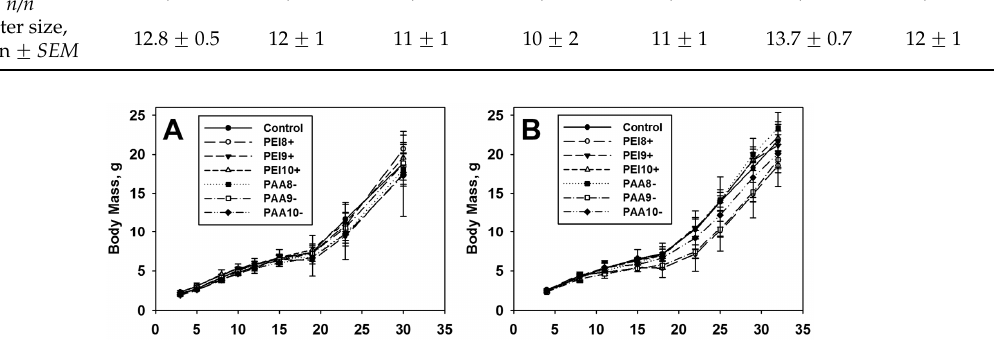
Table 4. Litter parameters for offspring exposed to 10 mg/kg ( A ) or 100 mg/kg ( B ) of iron oxide NPs on GD 8, 9, or 10 in utero . Litter size represents results from cesarean evaluations and pups birthed naturally. * Significant differences between treatment and control ( p < 0.05). Controls from both replicates were combined for litter size analyses as they underwent identical treatments. ‡ Trends between treatment and control at ( p < 0.1).